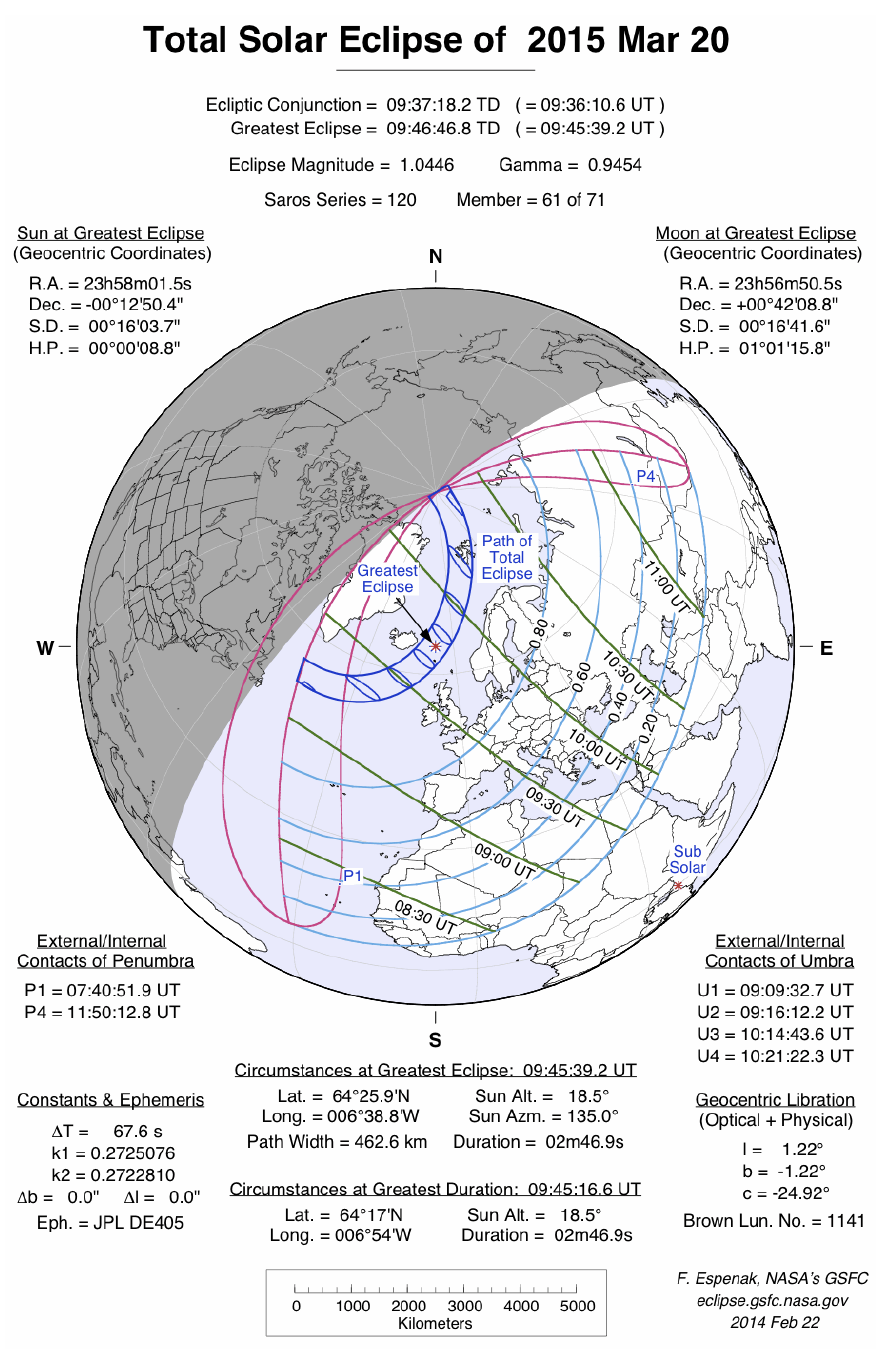
Figure 1. Map of the March 20, 2015, eclipse path on Earth. Total eclipse is visible within the dark blue areas; partial eclipse is visible within the light blue areas. The eclipse occurs at sunrise or sunset in the pink areas. Light blue lines represent a constant fixed fraction of coverage. Green lines show the time for greatest coverage. Figure from